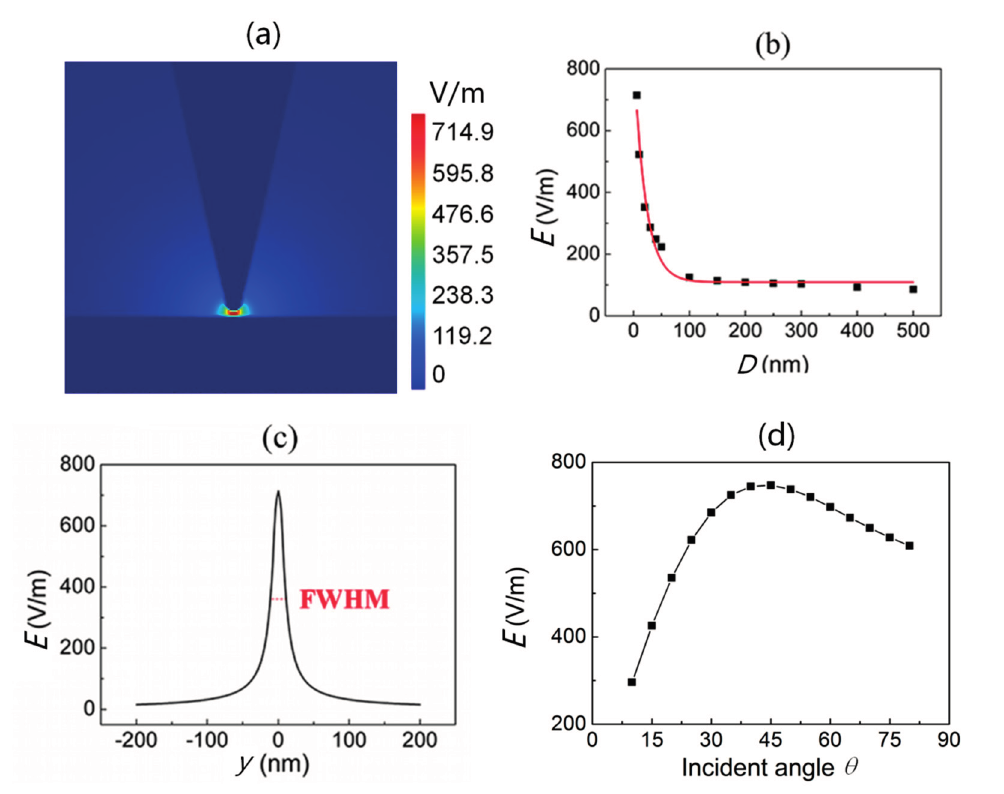
Figure 3. ( a ) The electric field distribution of Au nanotip-Au substrate; ( b ) Relation between the maximum electric field amplitude E and the nanotip-substrate distance D . The solid line is for the guide of eyes; ( c ) The electric field distribution along the y -axis for the Au nanotip-Au substrate system and the FWHM is marked with a dash line; ( d ) The maximum electric field amplitude E as a function of incident angle θ